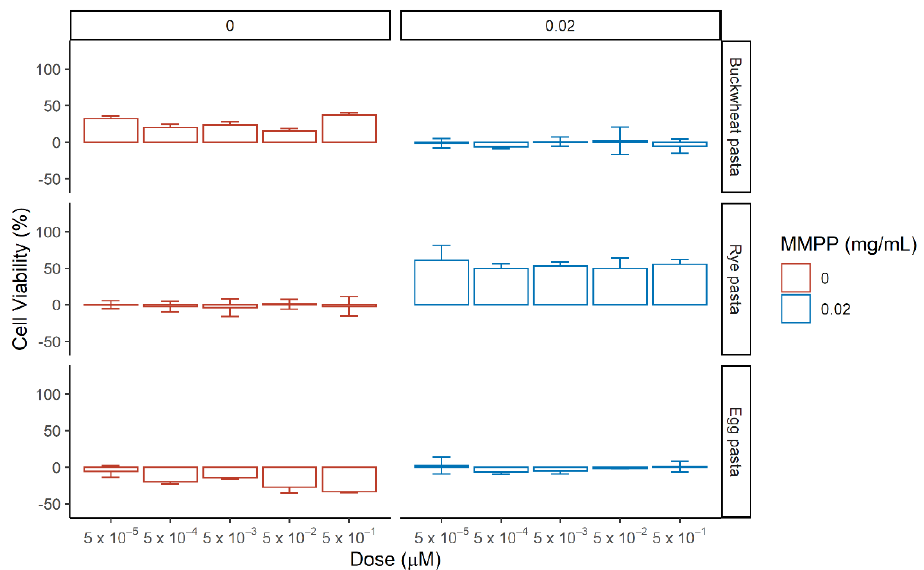
Figure 9. Effect of the pasta-derived hydroalcoholic extracts on the cell viability of MDCK in the absence (left, red) or presence (right, blue) of MMPP after 24 h incubation. Reported values correspond to mean of the difference in cell viability between tested phytocomplexes and reference (medium in red, and MMPP in blue) with standard error over three biological replicates. The percentage of cell viability was calculated using the ratio Abs TEST /Abs CTRL